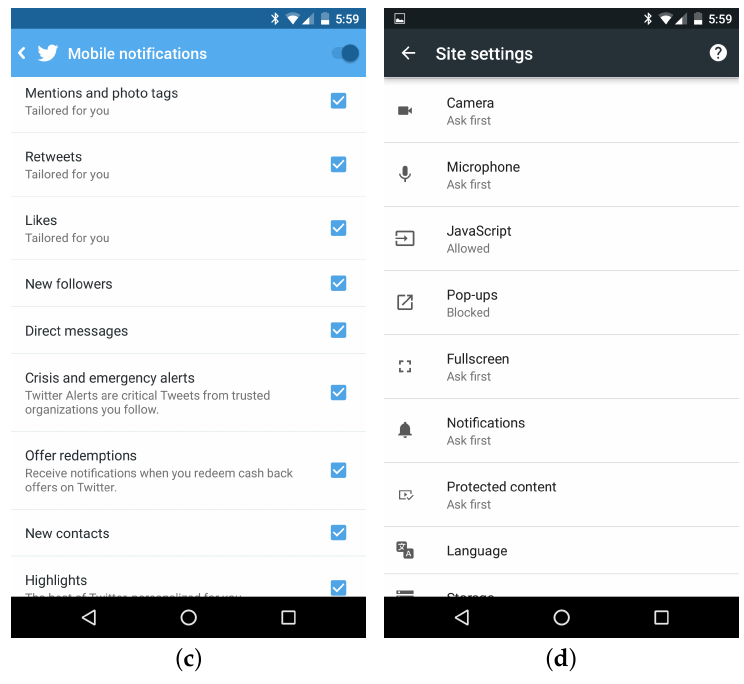
Figure 1. Push notifications: default behavior of popular mobile applications. ( a ) Google Play Service screen showing heartbeat and connection status; ( b ) default Facebook notification settings; ( c ) default Twitter notification settings; ( d ) push notification through Chrome mobile web